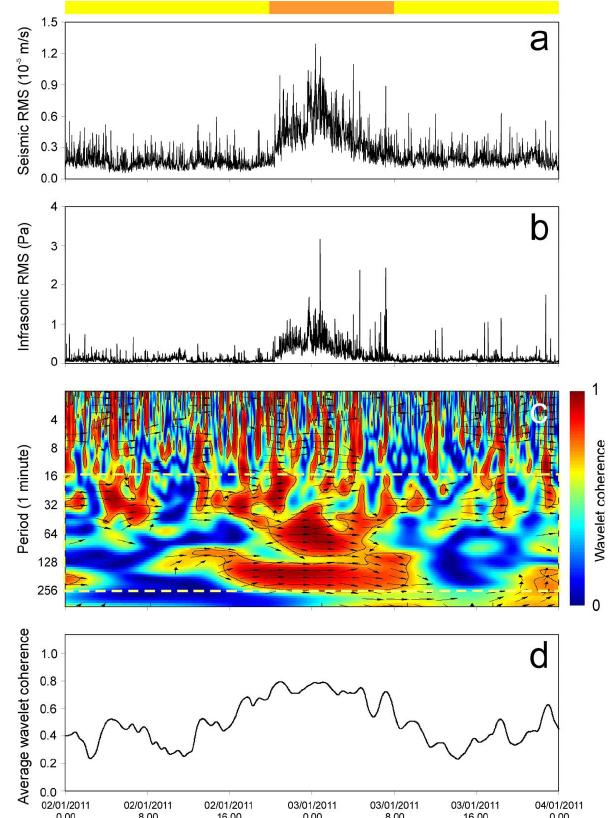
Fig. 4. (a) RMS velocity of the vertical component of the seismic signal at EBEL station calculated on 1-min-long windows filtered in the band 0.5–5.5Hz. (b) RMS pressure of the infrasonic signal recorded by EBEL station calculated on 1-min-long windows fil- tered in the band 0.5–5.5Hz. (c) WTC between the time series in (a) and (b) . The 5% significance level against red noise is shown as a black contour. The black arrows indicate the phase difference between infrasonic and seismic RMS (a horizontal arrow pointing from left to right signifies in phase and an arrow pointing vertically upward means the first series lags the second one by 90 ◦ ). (d) Vari- ation in time of coherence calculated by averaging the values falling in the yellow dashed rectangle in (c) . The yellow and red rectangles at top of (a) indicate the intervals characterised by mild and intense strombolian activity, respectively. WTC was computed by Matlab toolbox provided by Grinsted et al.